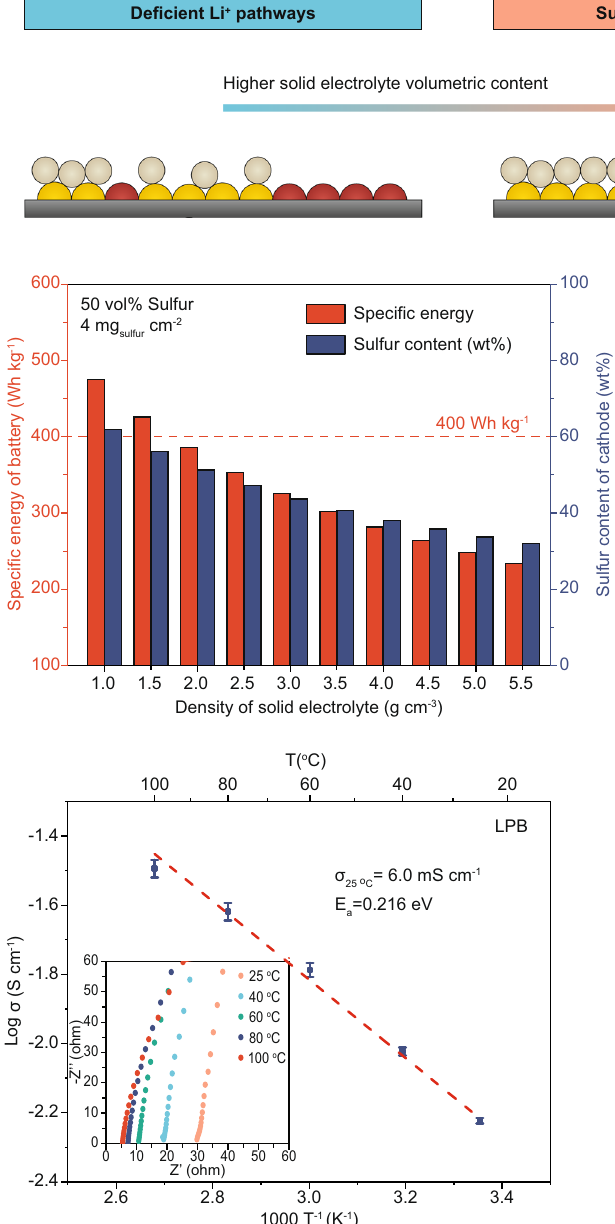
aqueousliquidelectrolytesolutions;PEO:poly(ethyleneoxide);LPB:Li 3 PS 4 -2LiBH 4 ; TTE: 1,1,2,2-tetra fl uoroethyl-2,2,3,3-tetra fl uoropropyl ether; LPS: β -Li 3 PS 4 ; LGPS: Li 10 GeP 2 S 12 ; LATP: Li 1.3 Al 0.3 Ti 1.7 (PO 4 ) 3 ; LLZO: Li 7 La 3 Zr 2 O 12 . d Arrhenius plot for hot- pressed LPB SE pellet and the corresponding Nyquist impedance plot of the Al-C| LPB|Al-C coin cell tested from 25 to 100 o C. The error bar represents the standard deviation of the measured ionic conductivity. e Comparison of ionic conductivity (20-30°C) and synthesis temperature of LPB SE and reported liquid-phase- synthesized sul fi de SEs 19 – 36